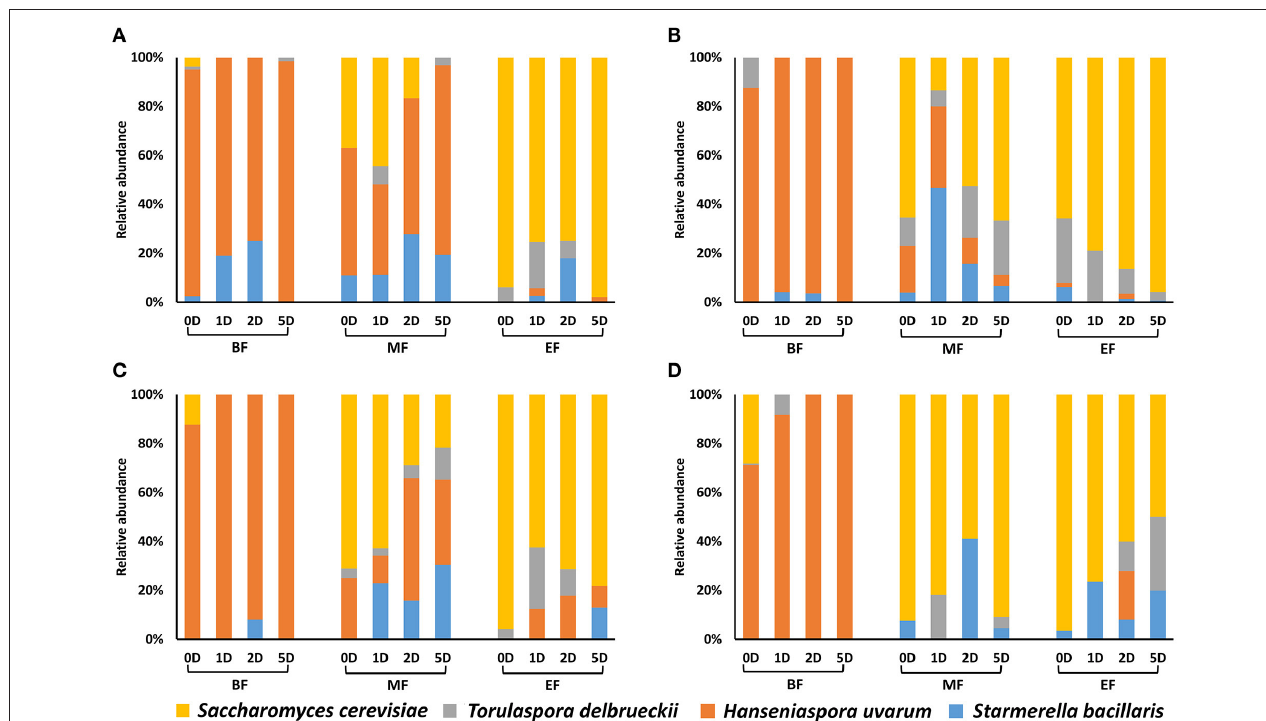
FIGURE 3 | Yeast population dynamics at the beginning (BF), middle (MF) and end of the fermentation (EF) under four different nutrient conditions, (A) 300N-200S, (B) 300N-240S, (C) 100N-200S, and (D) 100N-240S. The fermentations strategies were: 0D, co-inoculated fermentation; 1D, inoculation of S. cerevisiae at 24h; 2D, inoculation of S. cerevisiae at 48 h; and 5D, inoculation of S. cerevisiae at 5 days.